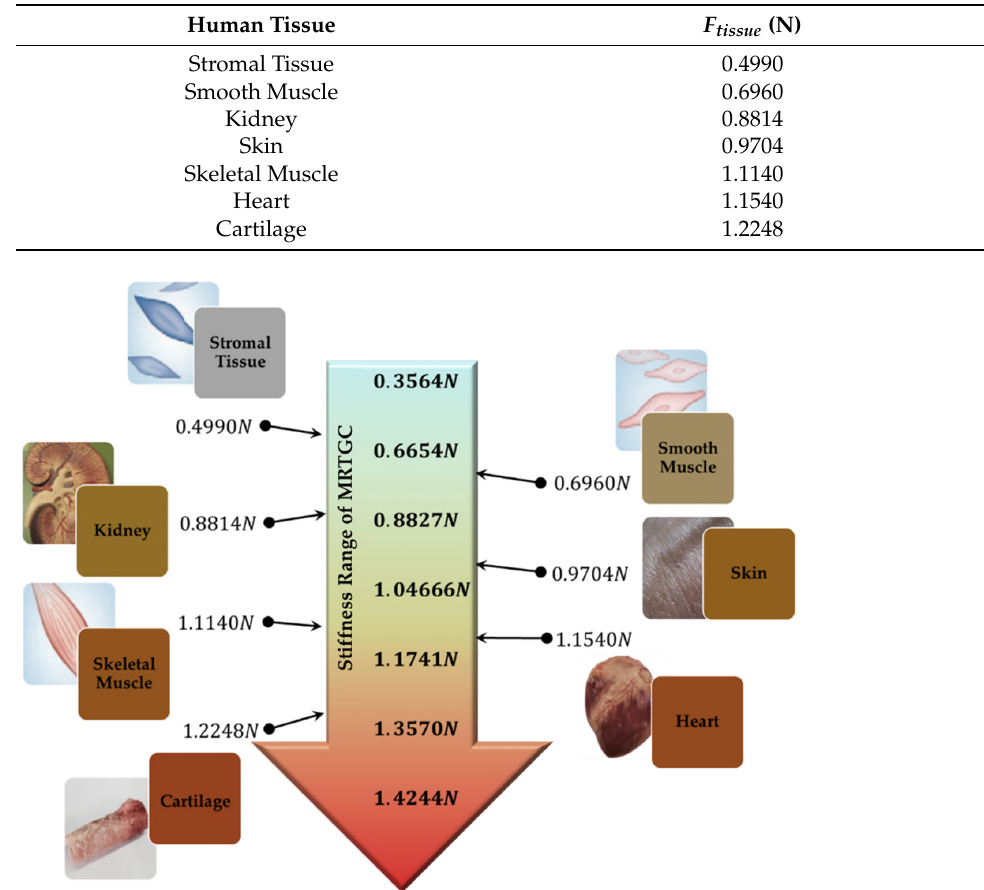
Figure 11. Elastic modulus of various types of human tissues [48,49]. Table 3. Calculated stiffness of human tissues from the elastic modulus.